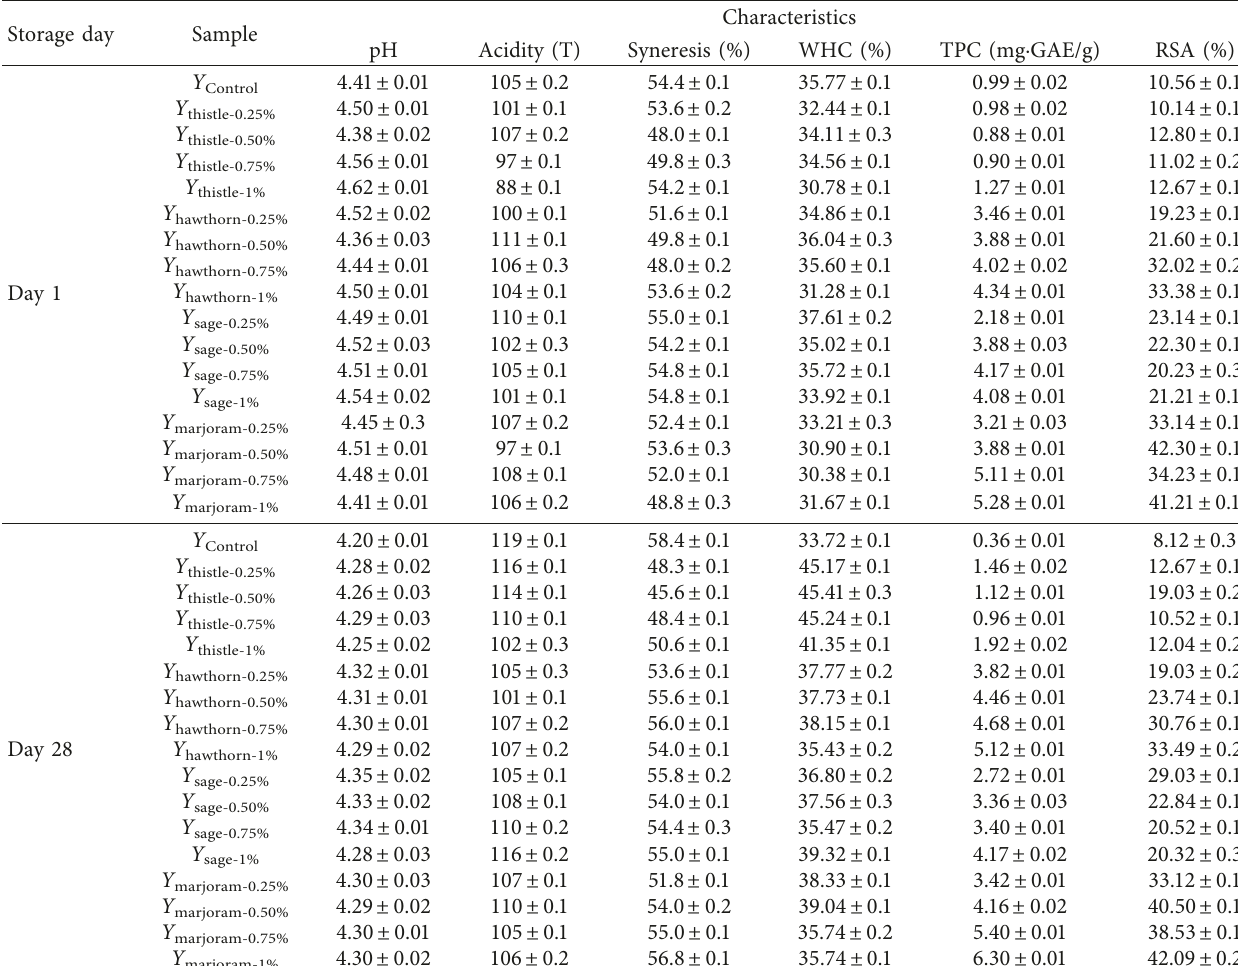
Table 1: Physicochemical characteristics and antioxidant activity of yogurt